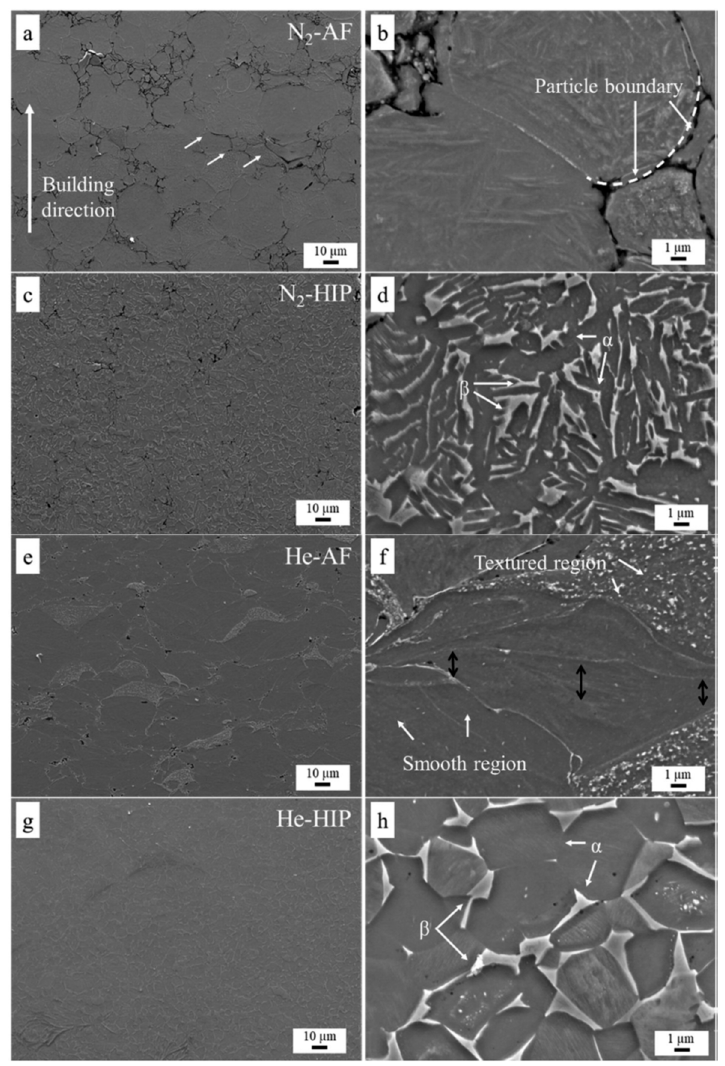
Figure 10. Effect of HIP on the microstructure of CSAM-ed Ti6Al4V, densification, and phase change. SEM images with ( a , c , e , g ) low magnification and ( b , d , f , h ) high magnification. Reprinted with permission from Ref. [238], Elsevier, 2019.